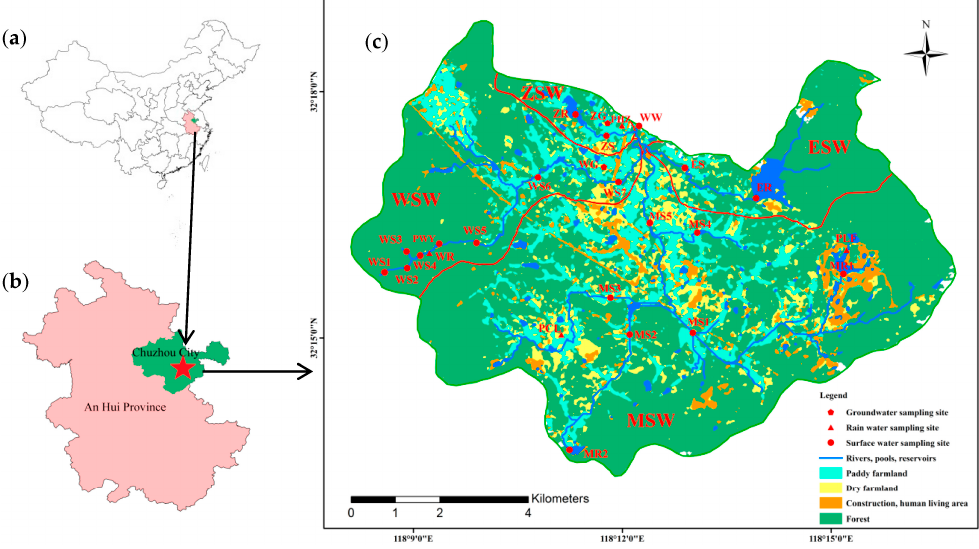
Figure 1. Location of the Huashan watershed in eastern China ( a ) and ( b ), along with its sub ‐ watersheds, water sampling sites (dots), and land use types ( c ). The whole watershed is divided into four sub ‐ watersheds ( red curves) based on the tributaries: Eastern sub ‐ watershed (ESW), Middle sub ‐ watershed (MSW), Western sub ‐ watershed (WSW), and Zhuyuangou sub ‐ watershed (ZSW).